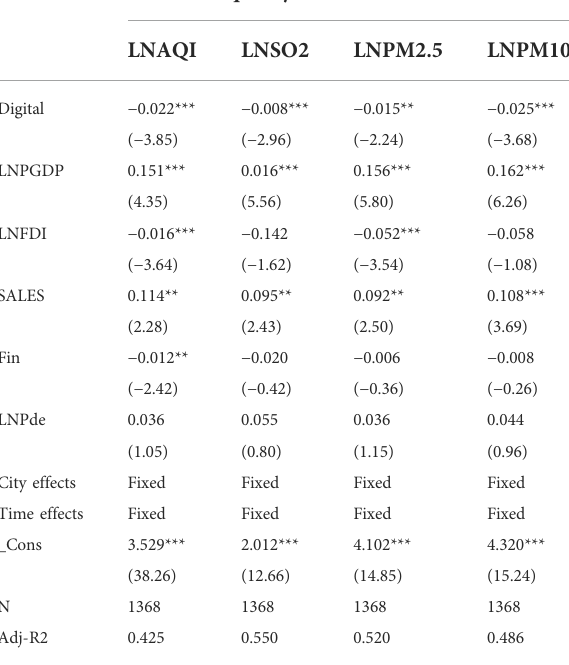
TABLE 2 Benchmark regression model